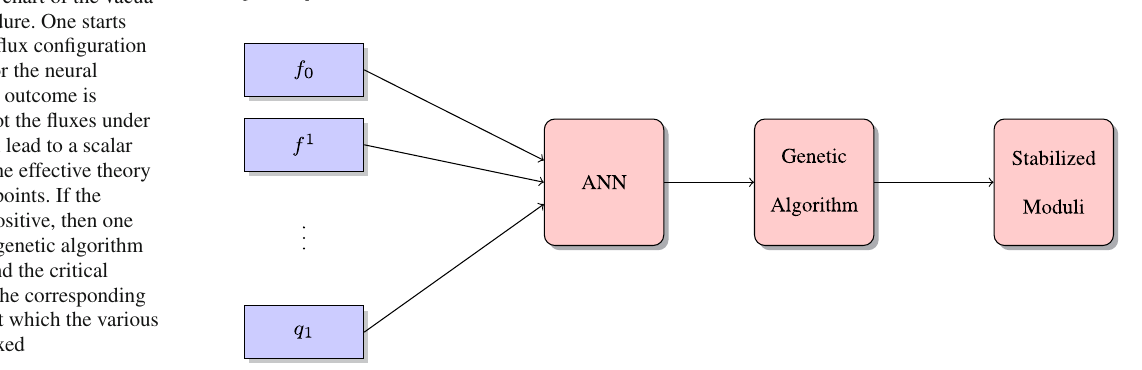
Fig. 2 Flow chart of the vacua search procedure. One starts with a given flux configuration as an input for the neural network. The outcome is whether or not the fluxes under consideration lead to a scalar potential in the effective theory with critical points. If the outcome is positive, then one employs the genetic algorithm in order to find the critical point(s) and the corresponding field values at which the various moduli get